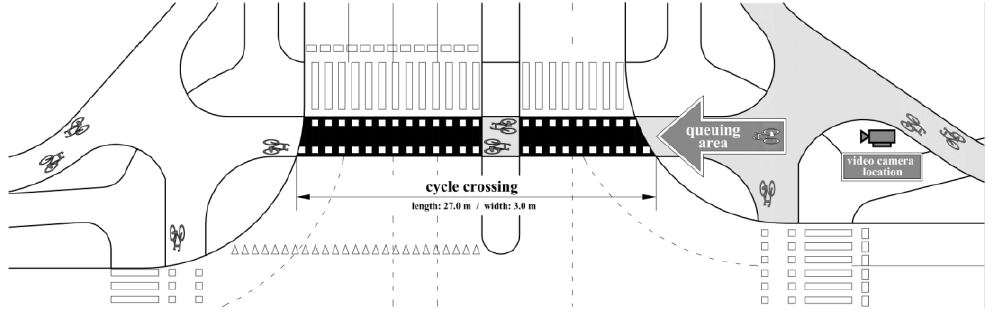
Figure 2. Cycleway crossing analysed in the paper